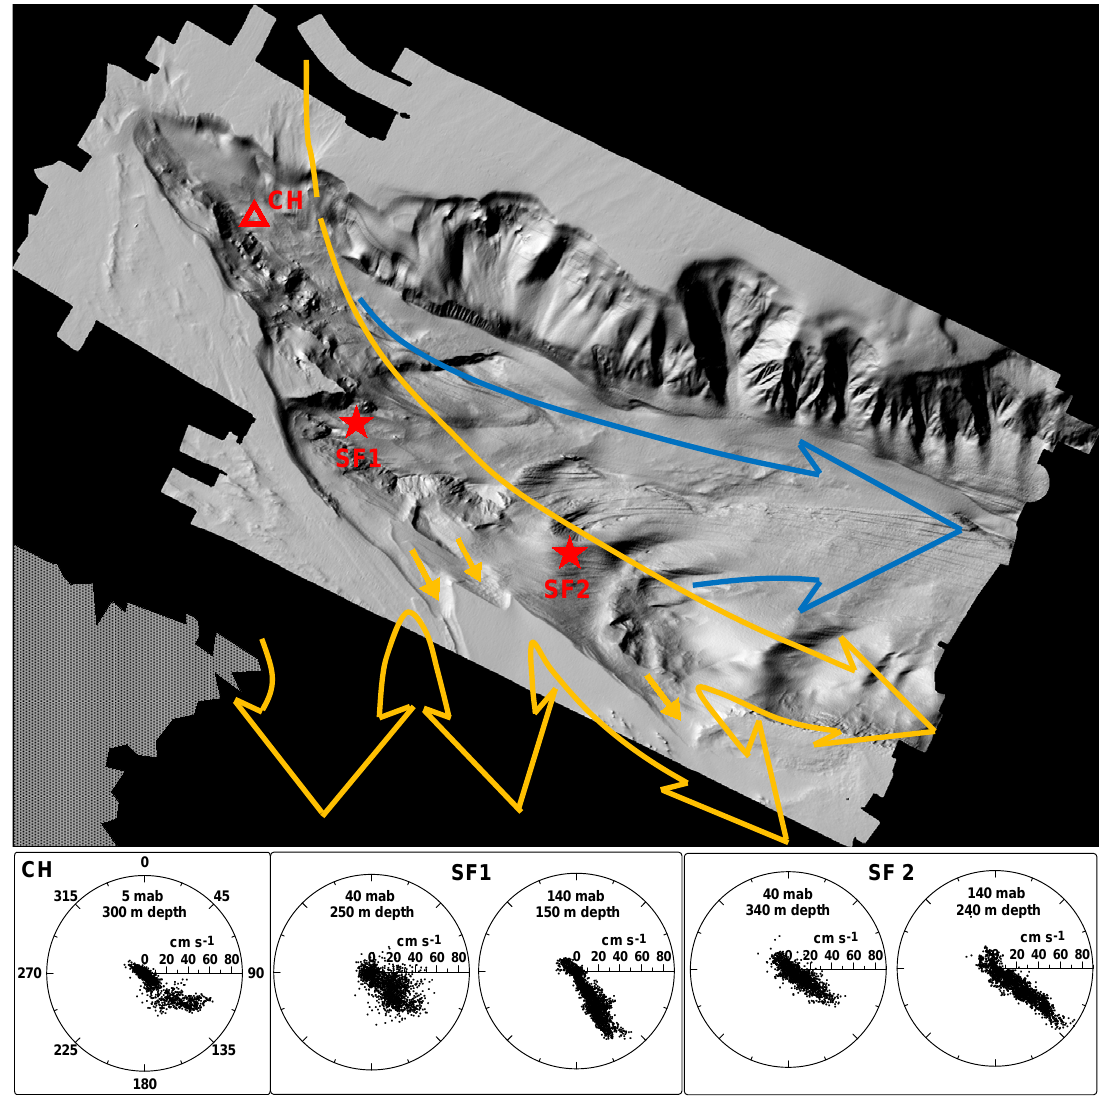
Fig. 12. Top: multibeam bathymetric map of the CCC, showing the main path of deep dense shelf water cascading (blue arrow) over a furrow field (see Puig et al., 2008), and the suggested path and exit routes for intermediate storm-downwelled shelf waters (orange arrows), hugging the southern canyon flank and causing scars on the canyon rims on the exit routes. Bottom: polar plots obtained from the canyon head station (CH, 5mab) and the topmost (140mab) and bottommost (50mab) usable ADCP cells at the two mooring sites along the southern CCC flank are also